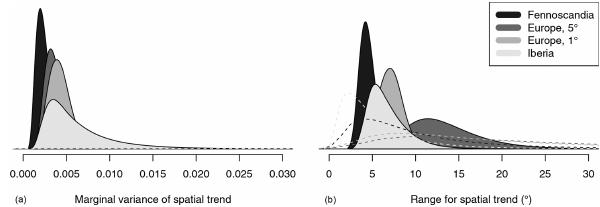
Figure 6. Posterior distributions of the marginal variance ( a ; Eq. 5) and the range parameter ( b ; Eq. 6) for the spatial trend coefficient for all four data sets. Prior distributions for each data set are indi- cated with dashed lines.